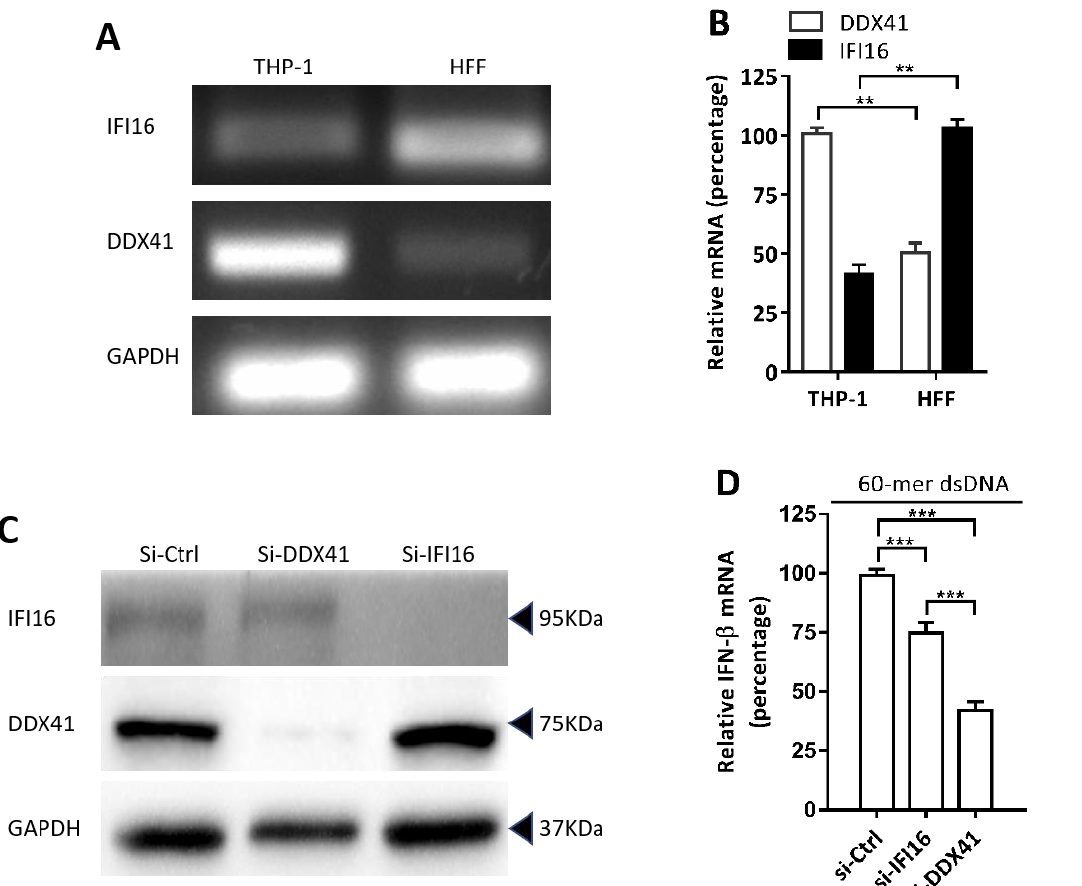
Figure 4. DDX41 was a crucial DNA sensor in THP-1 cells. ( A and B ) Total RNA was extracted from THP-1 or HFF cells and used for determining the expression of IFI16 and DDX41 by RT-PCR ( A ) and qRT-PCR ( B ), respectively. GAPDH was used as an internal control. ( C ) THP-1 cells were transfected with siRNA (final concentration of 50 nM) for the knockdown of DDX41 and IFI16 or nonspecific control (si-Ctrl), as indicated. After 24 h of transfection, the effects of knockdown of DDX41 and IFI16 were evaluated by immunoblotting, using GAPDH as a loading control. ( D ) THP-1 cells were treated with nonspecific control siRNA (si-Ctrl) or siRNA against IFI16 or DDX41, as indicated. After 24 h of treatment, THP-1 cells were transfected with HSV-1 60-mer dsDNA (final concentration of 1 µg/mL) for 8 h, and then the IFN- β mRNA level was determined by qRT-PCR. The values were normalized to GAPDH and standardized to 100% in the control groups, as indicated. Data are the means ± SD ( n = 3) from one representative experiment. Similar results were obtained from three independent experiments. ** P < 0.01; *** P < 0.01.